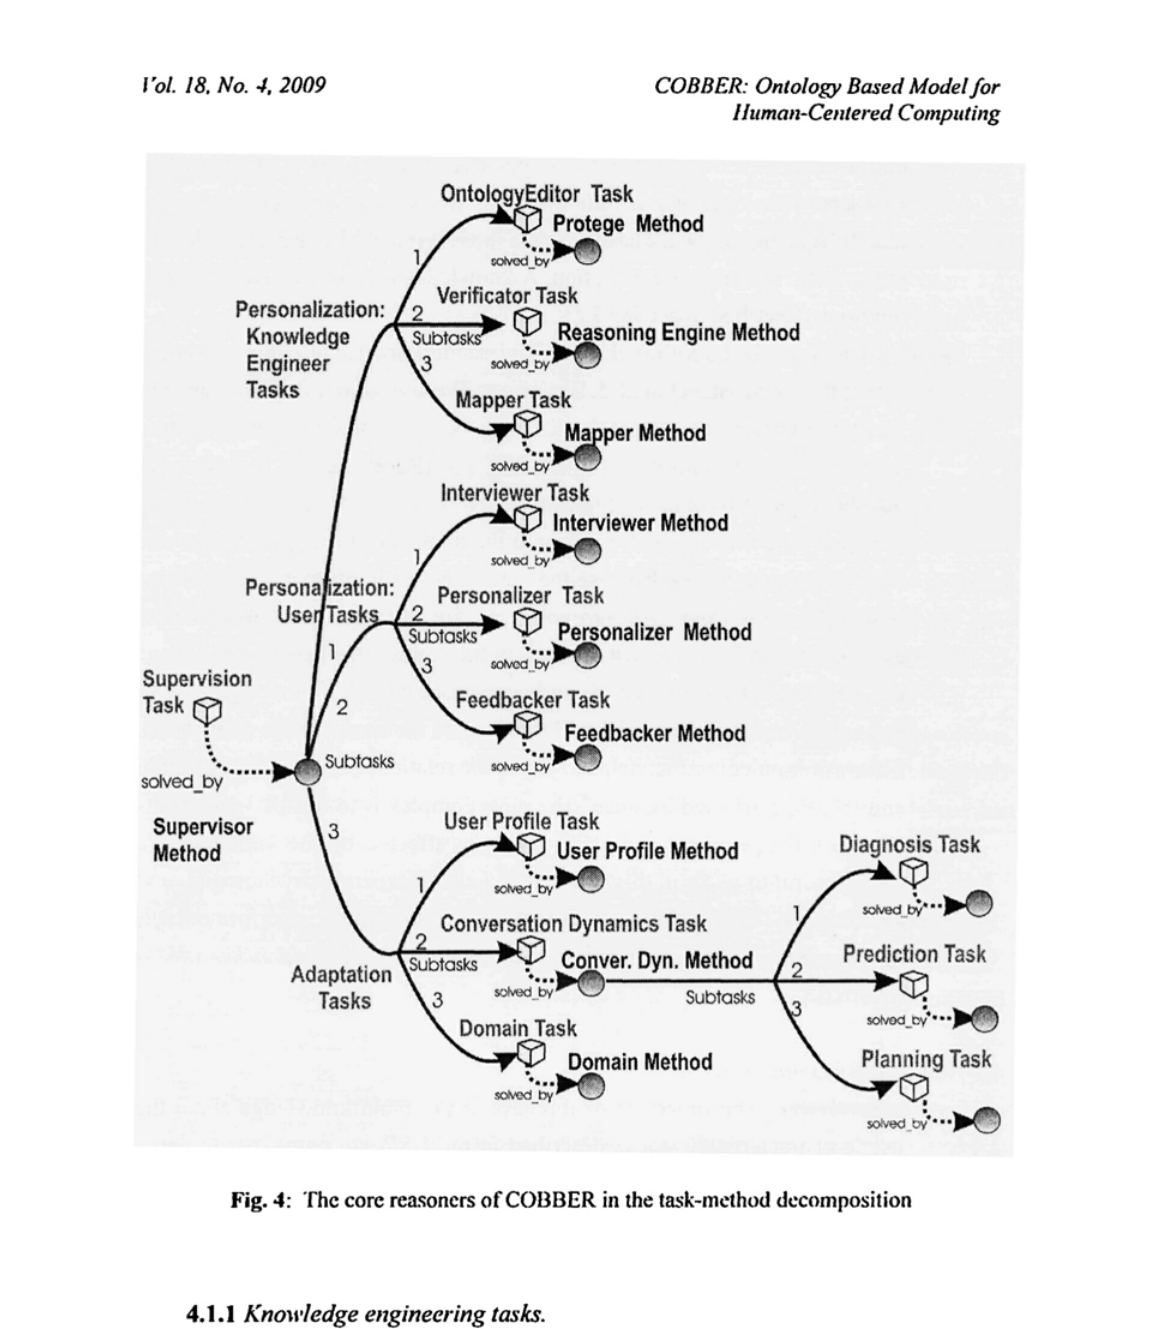
4.1.1 Knowledge engineering